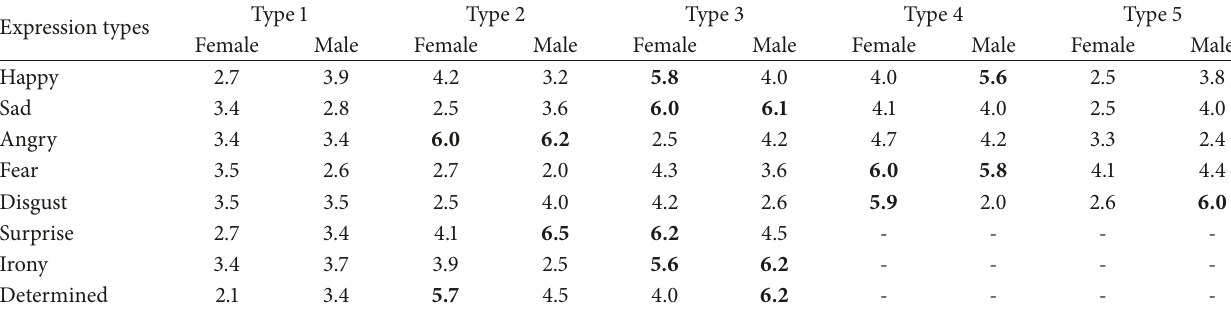
Table 4: Summarization of analysis results for male and female agents.